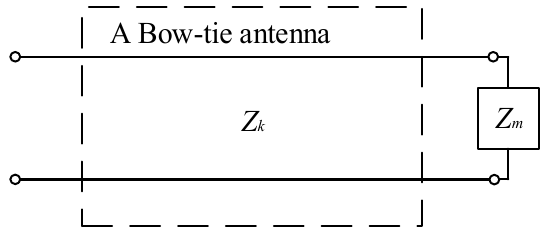
Figure 3. The Bow-tie antenna is terminated in a load impedance Z m .